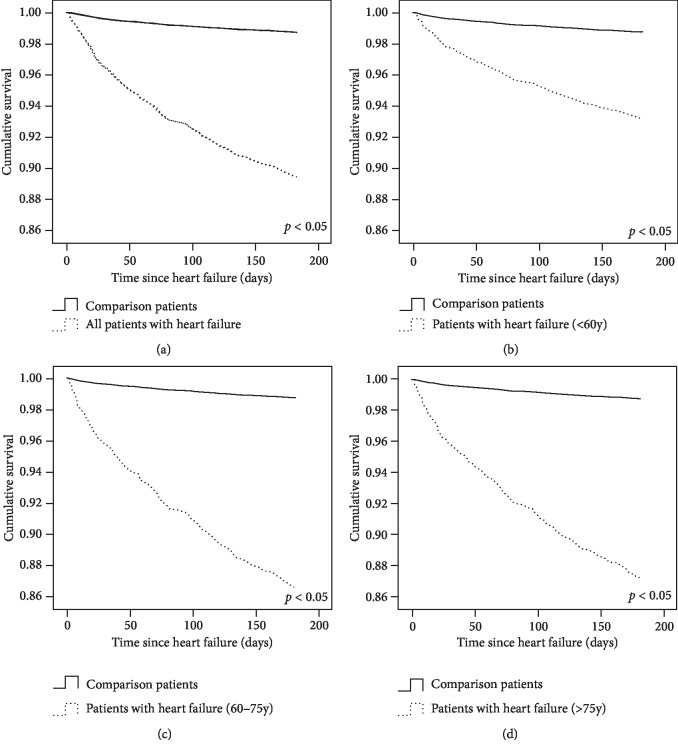
The heart failure-free survival curves of study and comparison patients during the follow-up period. The incidence of heart failure-free survival was significantly lower in OHCA patients than comparison patients (all age groups, p < 0.05). Heart failure occurred more quickly in patients aged 61–75 years (Figure 2(c)) than in those in the other age groups (Figures 2(a), 2(b), and 2(d)).